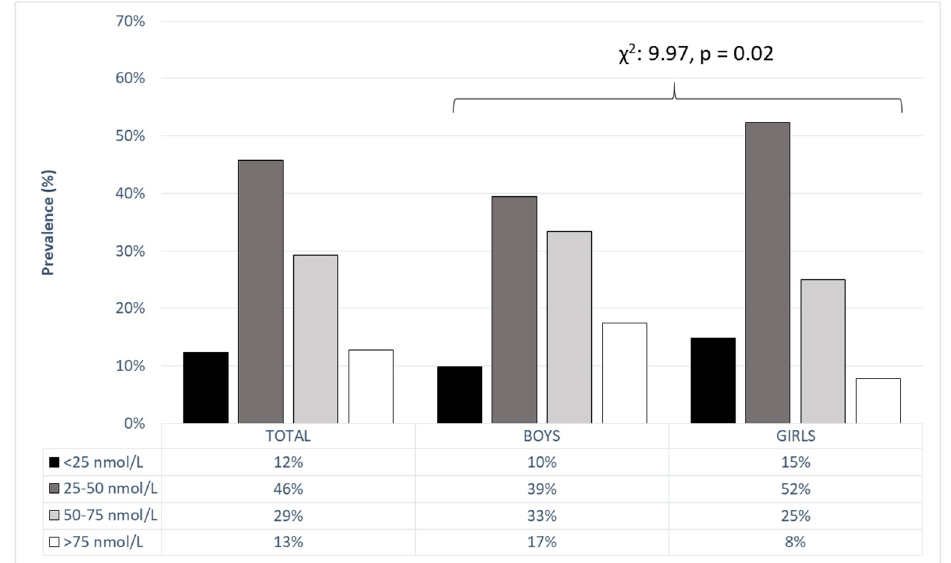
Figure 1. 25(OH)D levels in preschool children with differences between genders (Chi square ( χ 2 ) and level of significance ( p )).